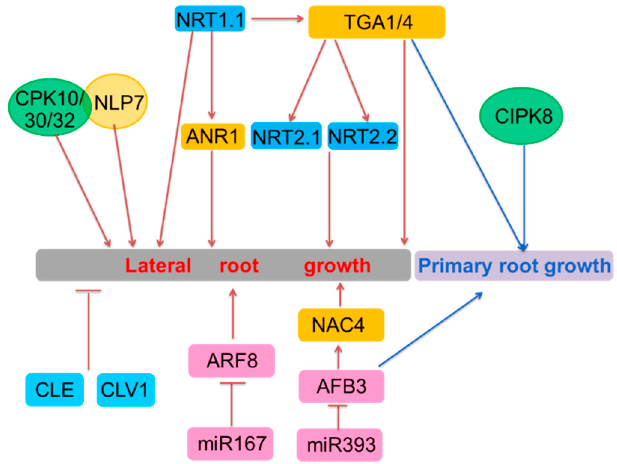
Figure 2. Schematic representation of primary and lateral root growth regulation by nitrate (local signaling). Arrows indicate positive regulation; blunted lines represent negative regulation. The dark blue boxes indicate the nitrate transporters; the yellow boxes indicate the transcription factors; the green boxes indicate the protein kinases; the light blue indicate the peptides; the pick boxes indicate the factors related to auxin.